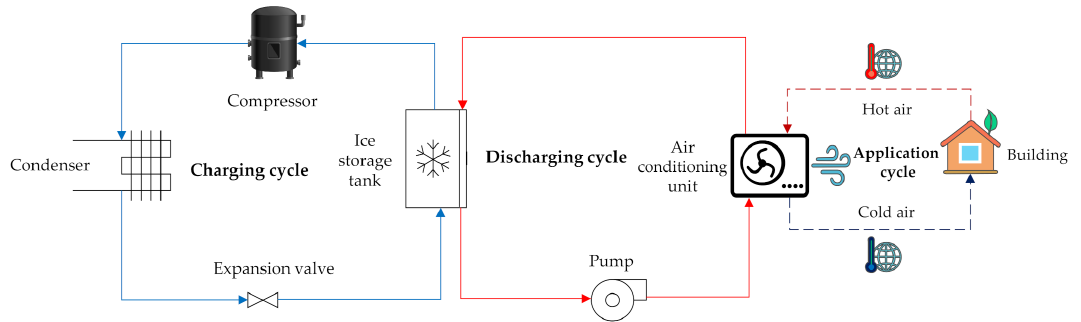
Figure 1. The thermodynamic cycles of charging, discharging, and application of the CES